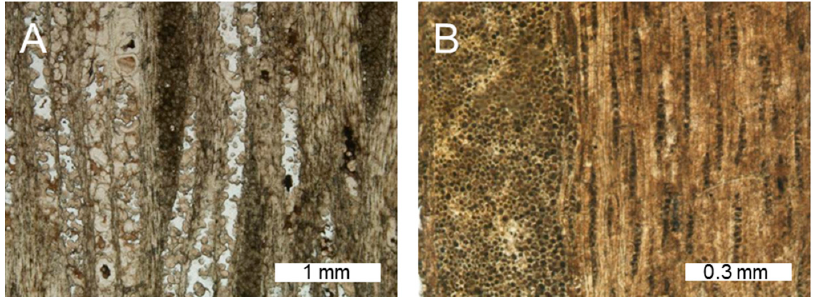
Figure 7. Petrographic thin sections of the 2014 specimen, tangential longitudinal plane. ( A , B ) show anatomical detail matching Schuster’s Table IV, Figures 1 and 2, respectively [7].